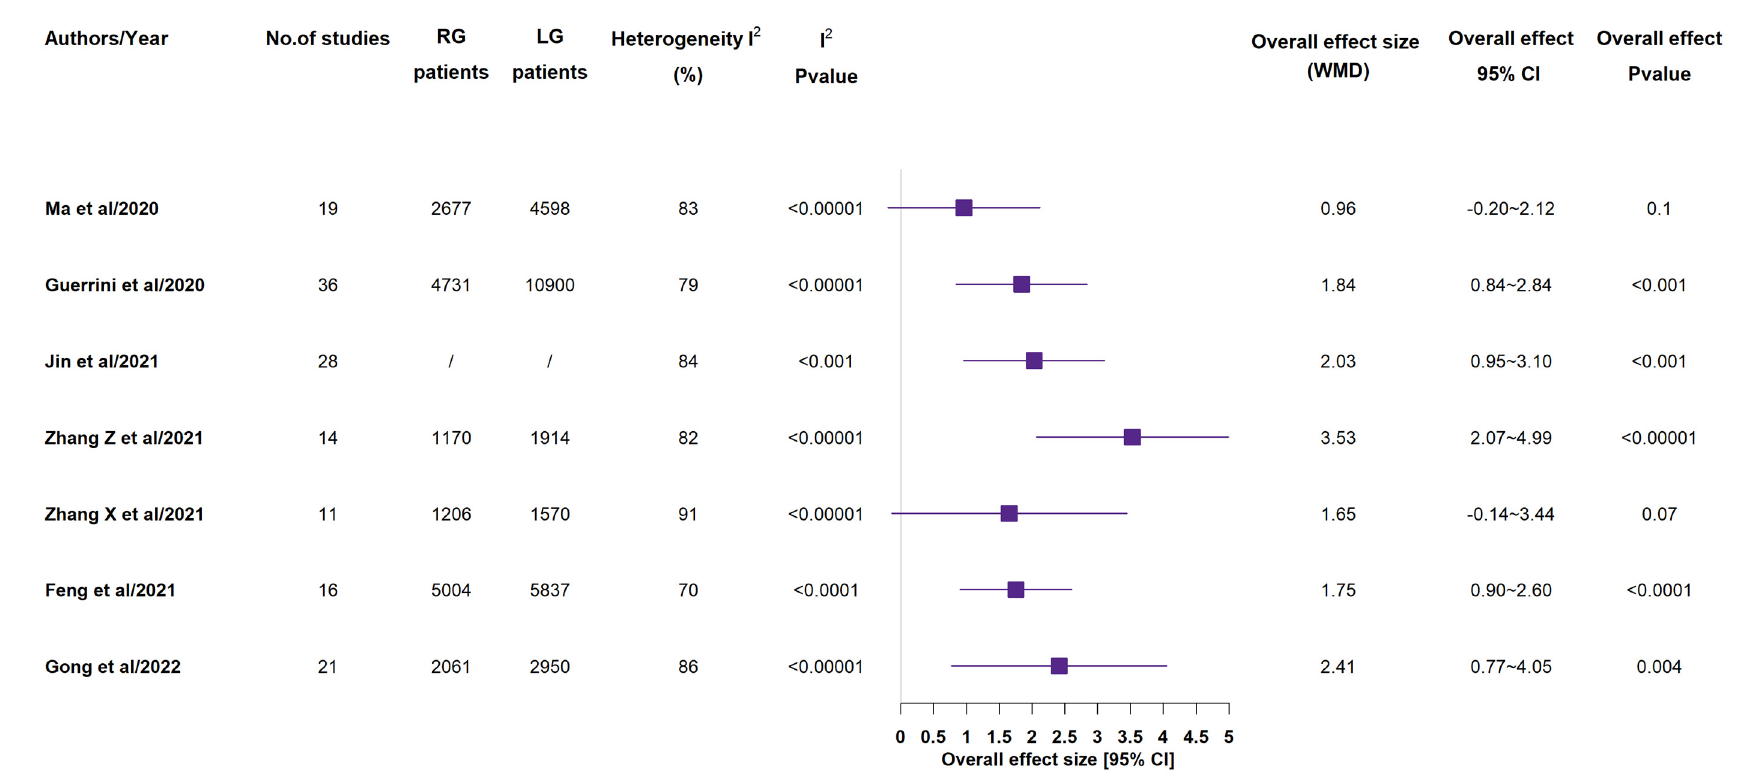
Figure 4. Retrieved lymph nodes (n). RG = Robotic gastrectomy; LG = Laparoscopic gastrectomy; WMD = weighted mean difference